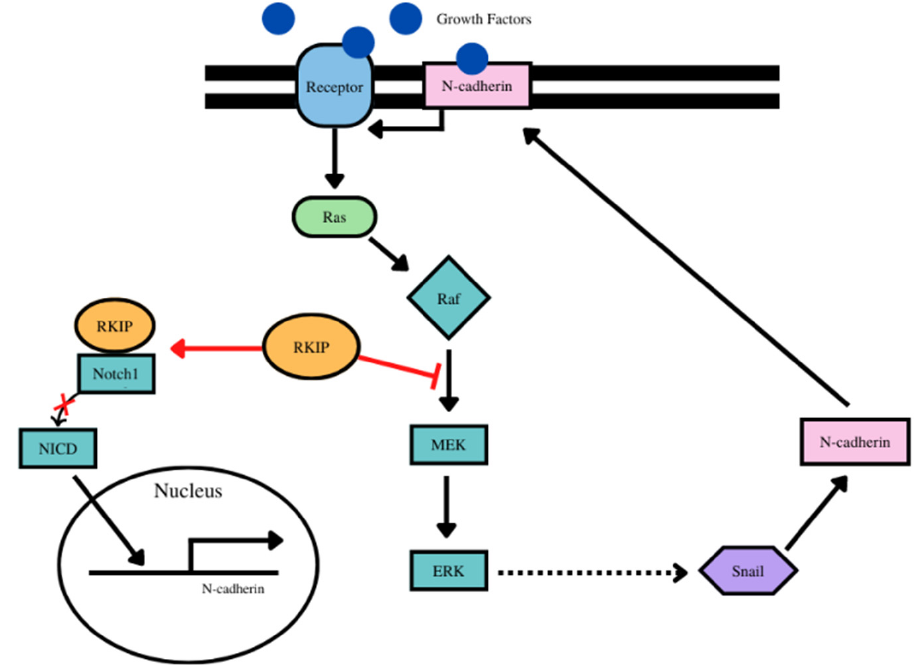
Figure 3. Crosstalk Between RKIP and N-cadherin. RKIP inhibits the MEK/ERK signaling pathway by interrupting the interaction between Raf and MEK, stopping the progression of the signal through the pathway. Snail is regulated downstream of the MEK/ERK pathway, upregulated through MEK/ERK signaling. Snail cannot promote N-cadherin production without MEK/ERK signaling, showing RKIP as an antagonist to N-cadherin expression. In addition, RKIP binds to Notch1, blocking the cleavage of NICD. NICD is then unable to locate to the nucleus to induce the transcription of N-cadherin.